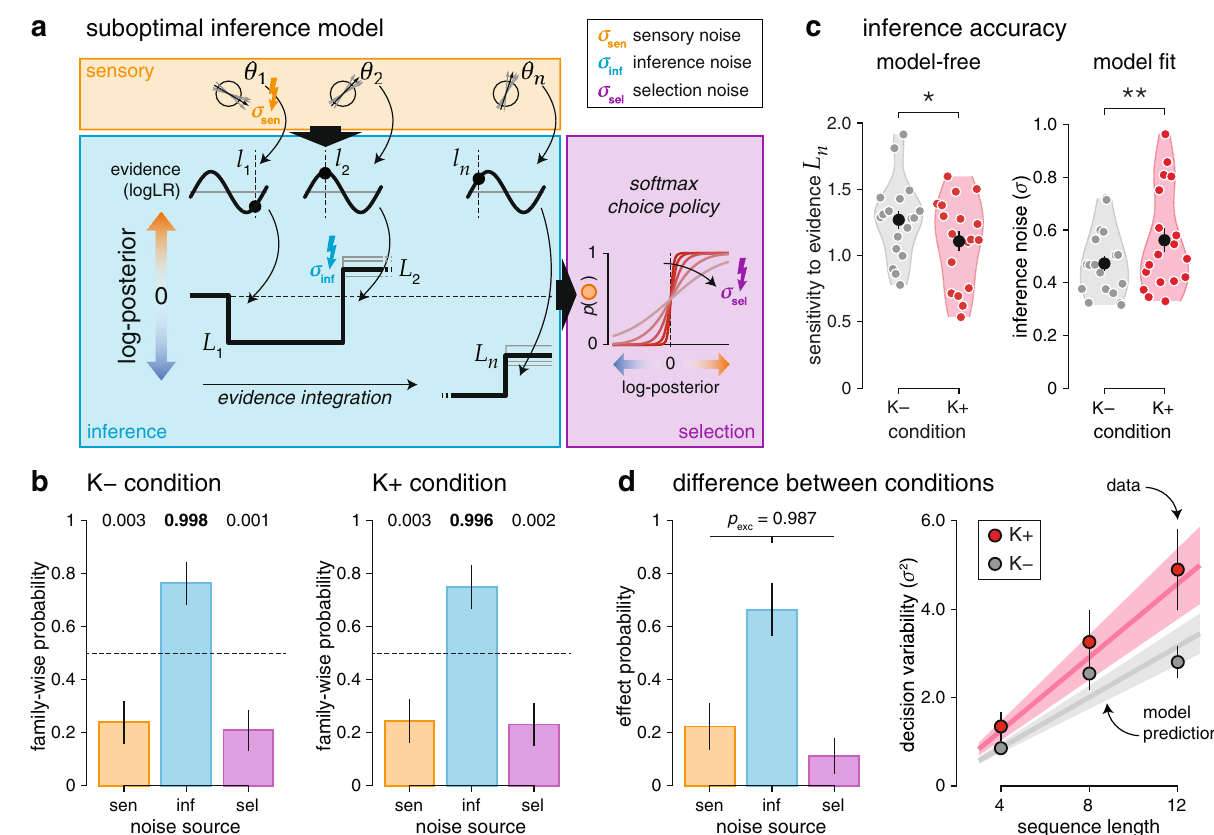
Fig. 3 Impaired cognitive inference under ketamine. a Suboptimal inference model. Bayes-optimal inference is achieved by estimating the evidence l k for each category (here, their log-likelihood ratio) provided by each stimulus of orientation θ k , accumulating this evidence across the n stimuli to obtain a posterior L n , and using this posterior to select the most likely category given the observed stimuli. Sensory noise is modeled by Gaussian noise of s.d. σ sen to each stimulus orientation θ k . Inference noise is modeled by Gaussian noise of s.d. σ inf to the evidence l k being accumulated. Selection noise is modeled by Gaussian noise of s.d. σ sel to the fi nal posterior L n . b Factorized Bayesian model selection procedure in the placebo (left) and ketamine (right) conditions. Family-wise probability is de fi ned as the probability of each noise source (sensory, inference, selection) independently of the presence or absence of other noise sources. Bars and error bars correspond to means ± s.d. of estimated Dirichlet distributions. Values above each bar indicate associated exceedance